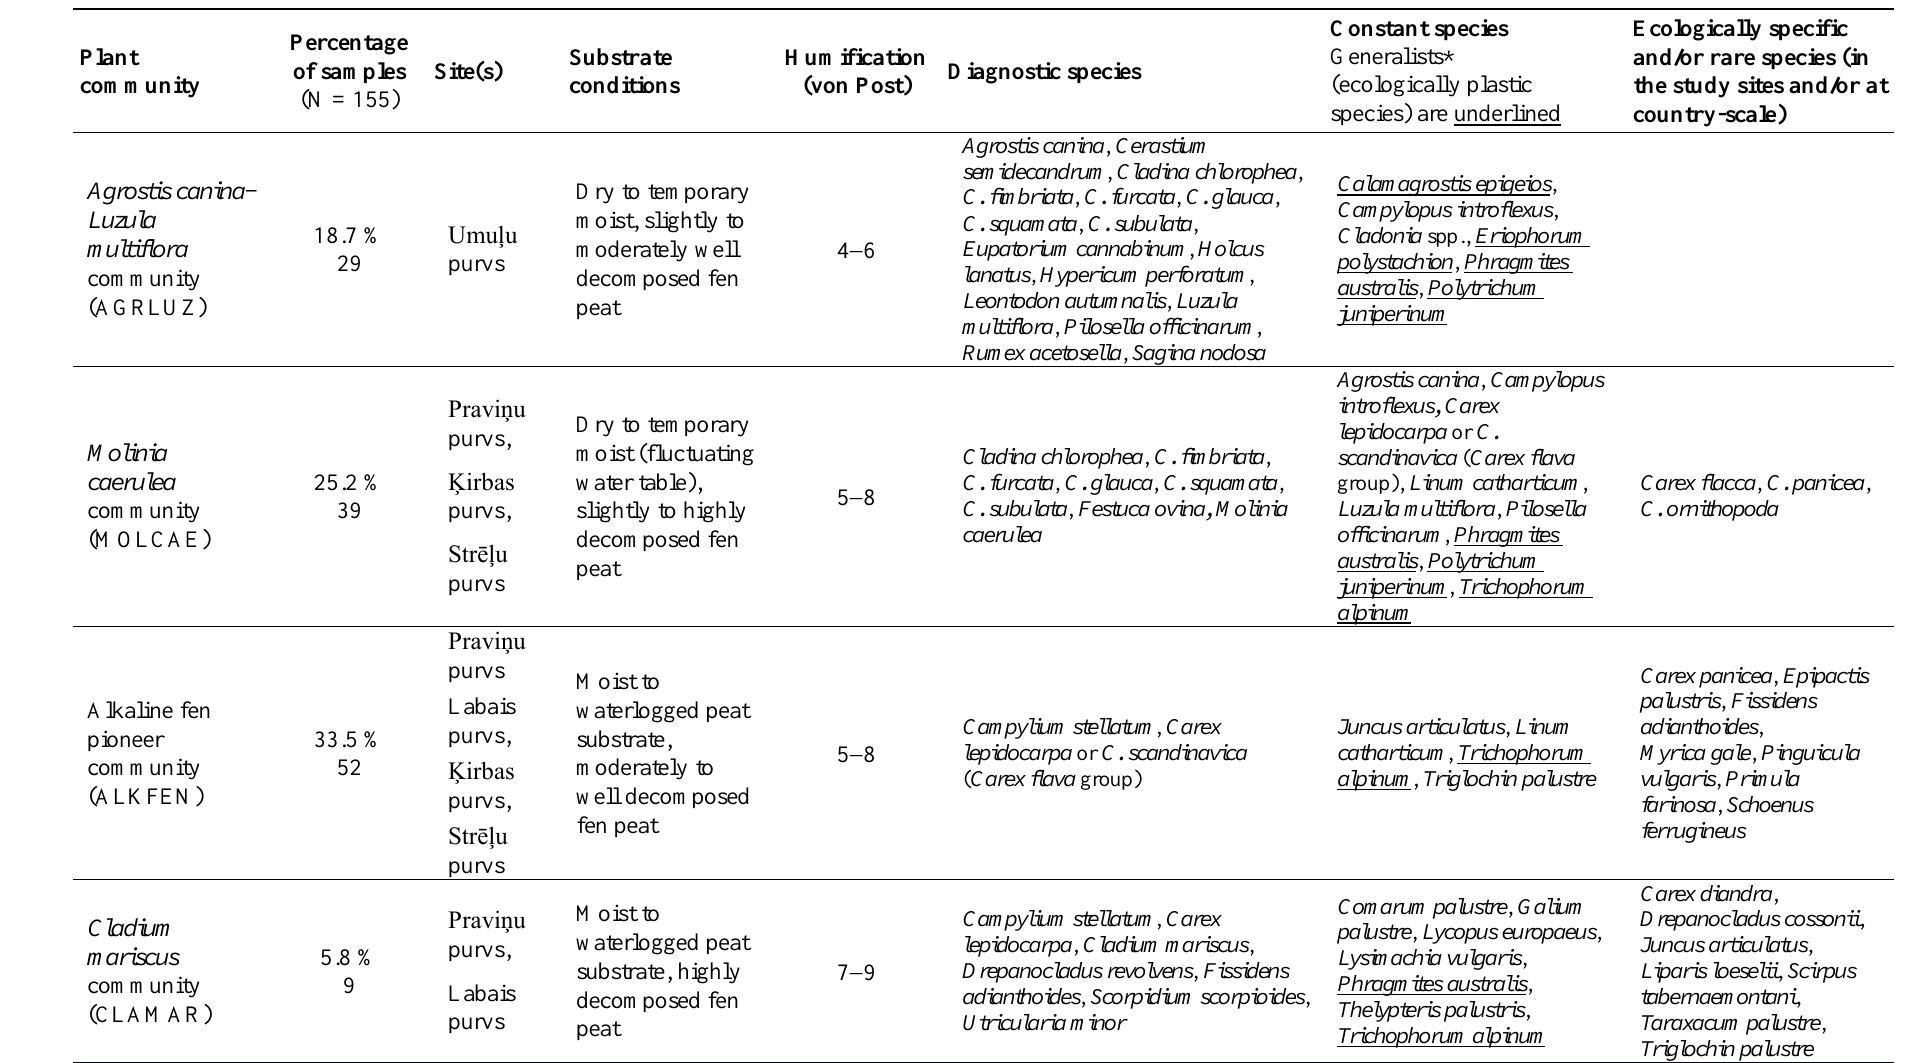
Table 2. Plant communities according to TWINSPAN division.